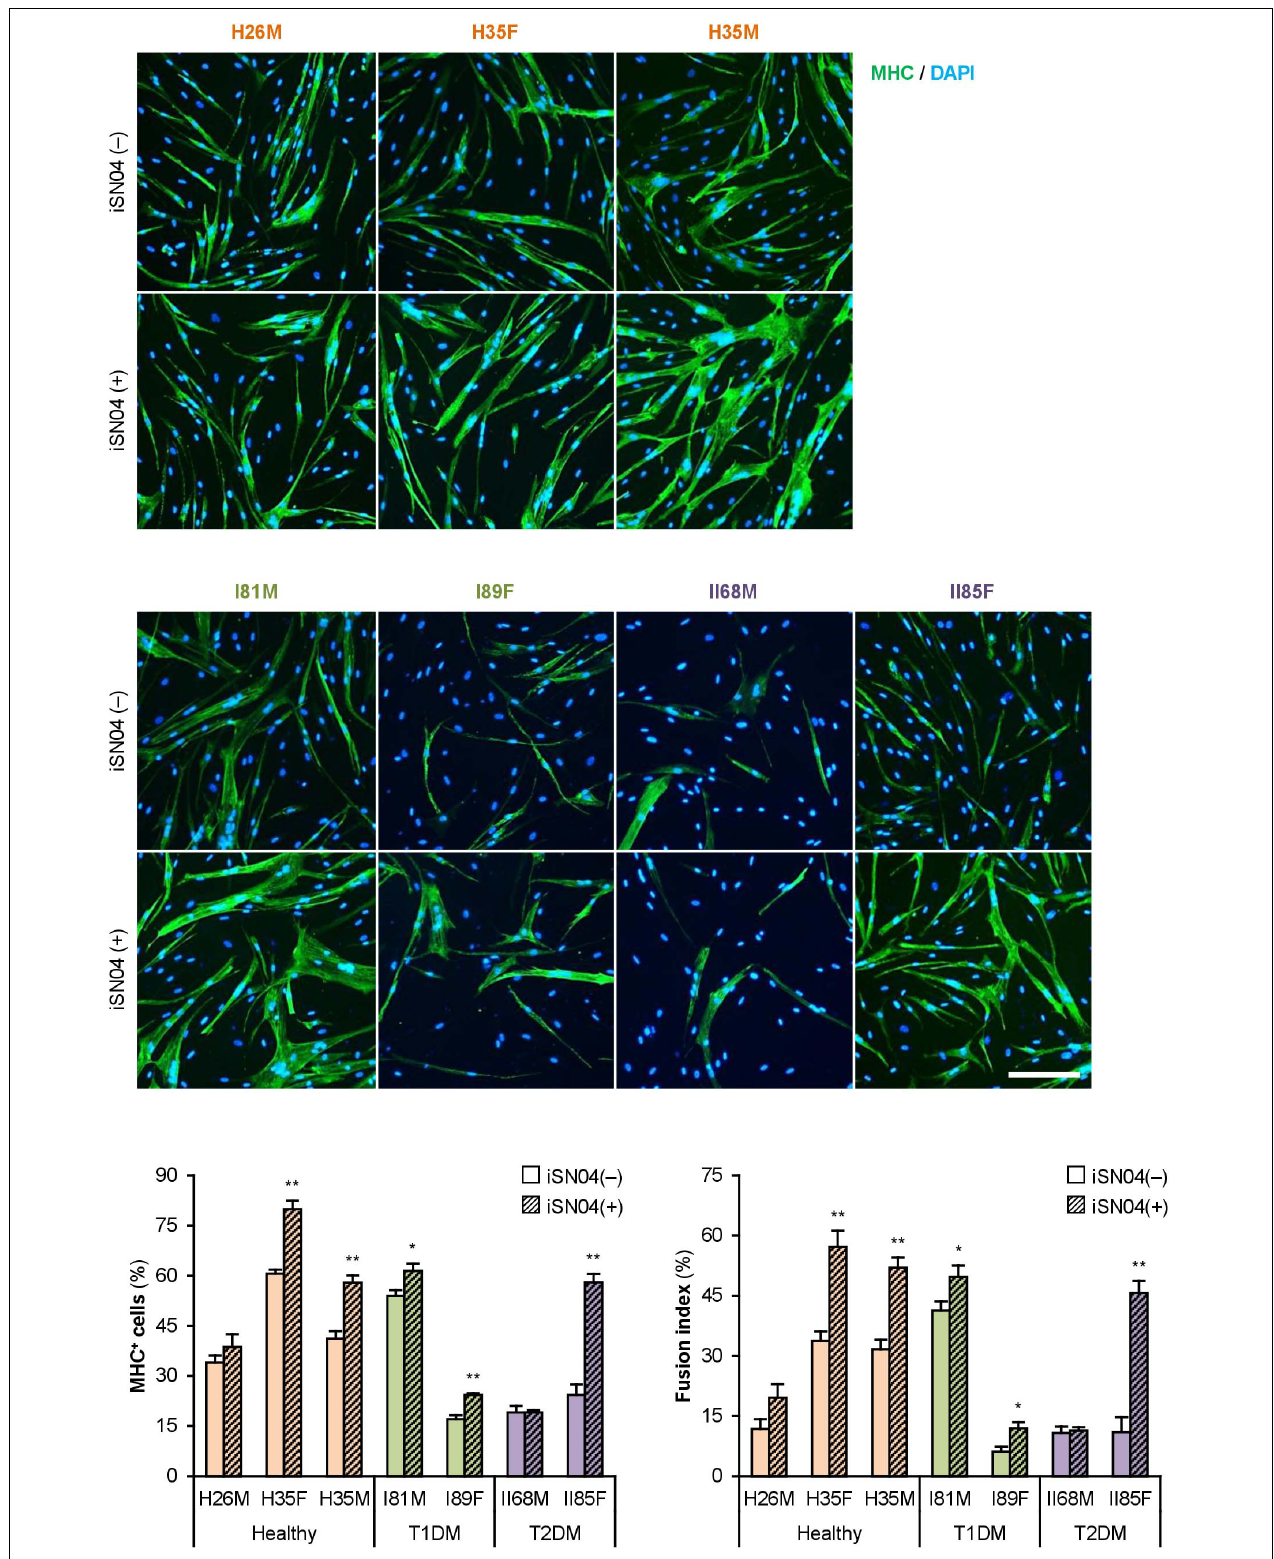
FIGURE 3 | iSN04 recovers the differentiation of DM myoblasts. Representative immunofluorescent images of the hMBs differentiated in DIM-NG with iSN04 for 2 days. Scale bar, 200 µ m. Ratio of MHC + cells and multinuclear myotubes were quantified. * p < 0.05, ** p < 0.01 vs. iSN04(–) in each group (Student’s t -test); n =